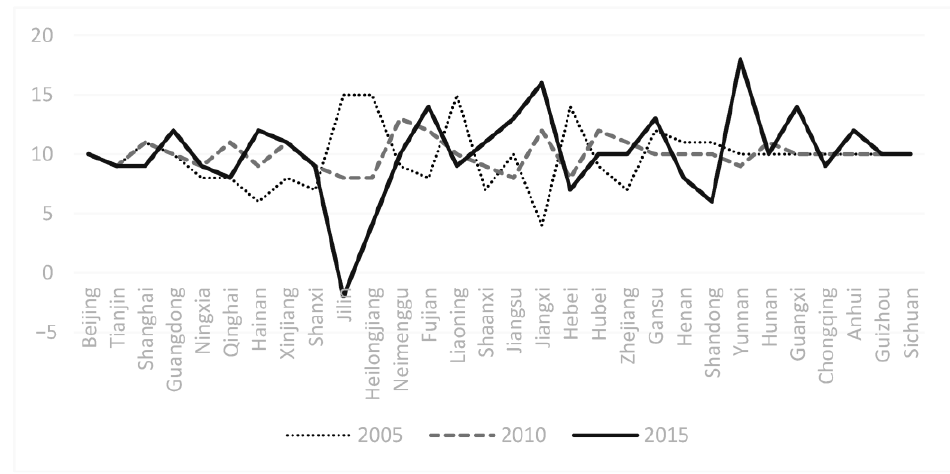
Figure 2. Ranking of average HA index from 2005 to 2015 and Trends of Provinces.